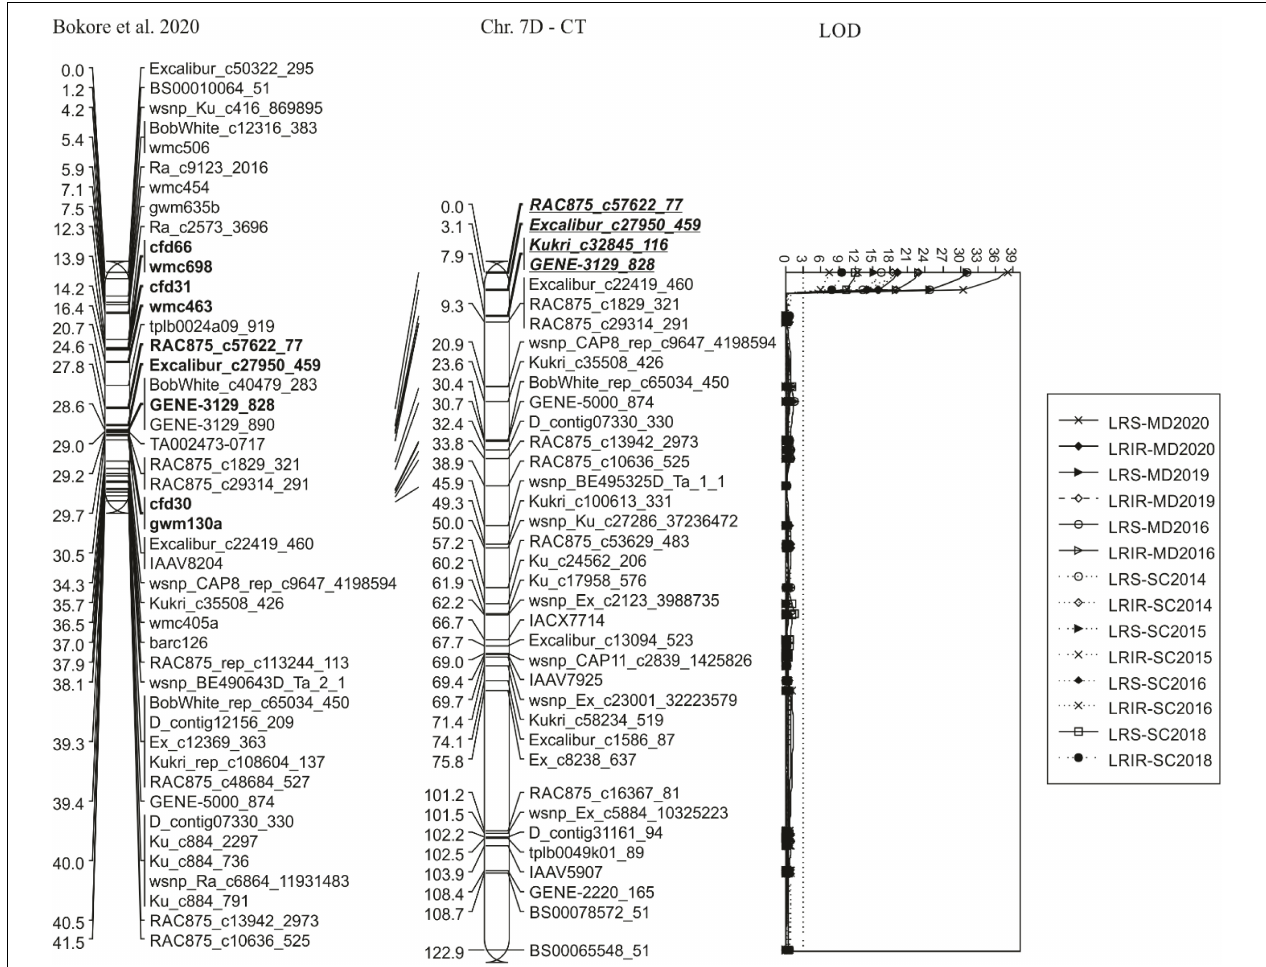
FIGURE 3 | Quantitative trait loci (QTL) for leaf rust resistance identified in Carberry/Thatcher (CT) population evaluated in seven field environments at the adult plant stage near Morden (MD), MB and Swift Current (SC), SK, Canada. QTL detected in the population on chromosome 4A, 4B, and 5B were not presented in graphs. Note that 2B.1 stands for QLr.spa-2B.1, 2B.2 for QLr.spa-2B.2, and 2B.3 for QLr.spa-2B.3. QLr.spa-2B. 3 was not detected by MapQTL and QTLNetwork as the main effect QTL, but it was revealed by epistasis analysis interacting with QLr.spa-2D . Disease traits, leaf rust severity (LRS) and leaf rust infection response (LRIR), and test locations Morden (MD) and Swift Current (SC) and the year of field evaluation. The Carberry/Thatcher (CT) population map was aligned with a hexaploid high density consensus map published by Bokore et al.